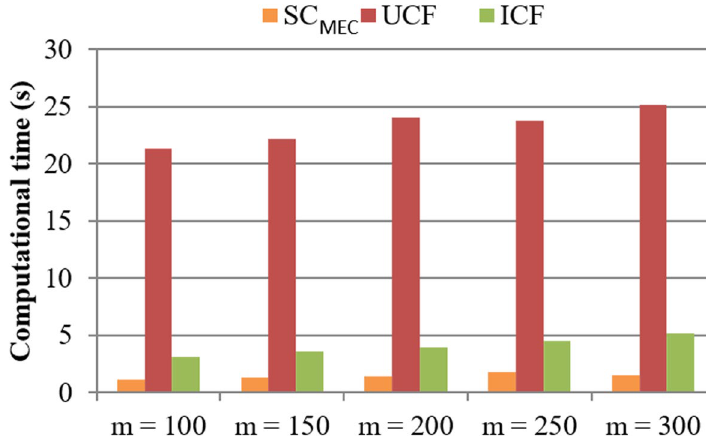
Fig. 2 Computational time comparison (w.r.t. m